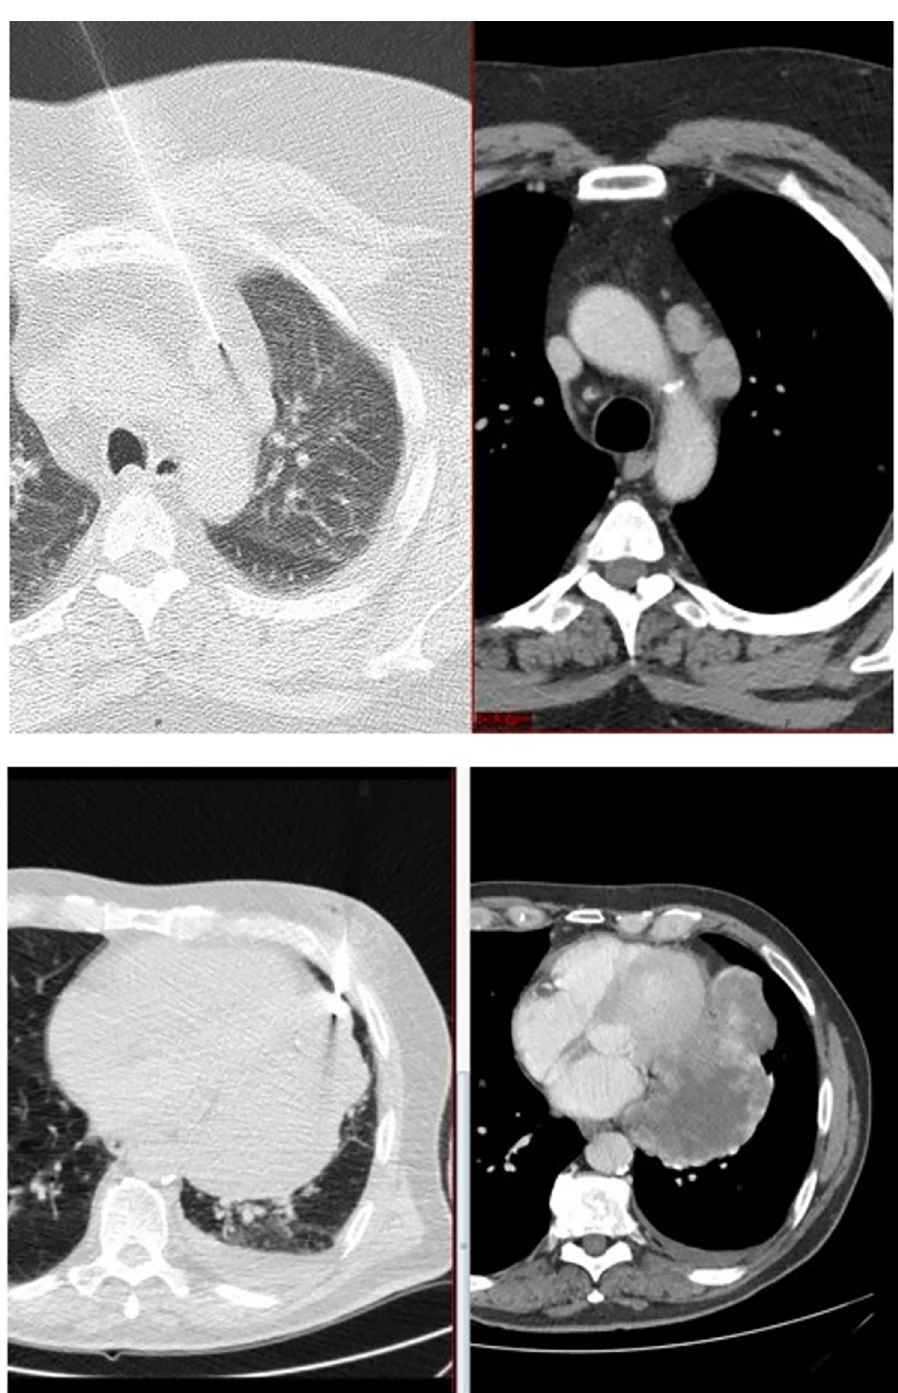
Fig 1. Two images of biopsies. Top: Shows a biopsy procedure with parasternal access. The lesion is located in Felson’s anterior compartment and in the superior compartment according to the anatomical division system. The diagnosis was metastasis from prostate cancer. Bottom: Shows a biopsy procedure with transpulmonal access. The lesion is located in Felson’s anterior compartment and in the inferior anterior compartment according to the anatomical division system. The diagnosis was